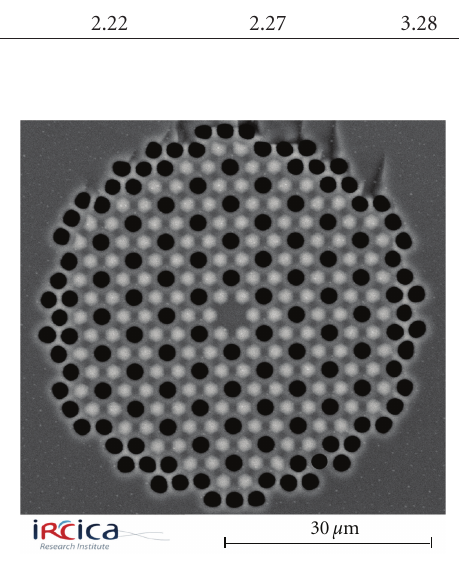
Figure 1: SEM image of the solid-core PBG fiber 1. Black regions are air holes, light gray regions are GeO 2 -doped inclusions, and the dark gray background is pure silica.